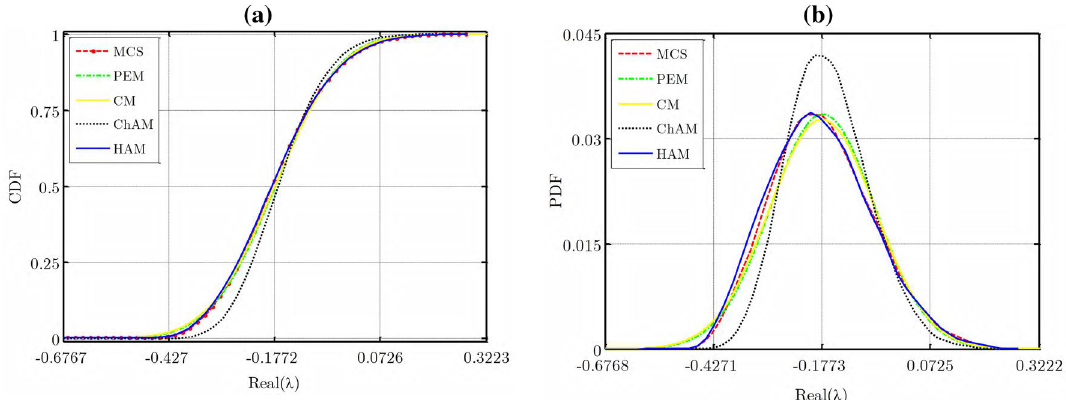
Fig. 8 a Cumulative distribution function, and b Probability distribution function of the real part of the mode#2 eigenvalue of the 6th gen- erator ( 𝜆 2, G 6 ) , in IEEE 14-bus system